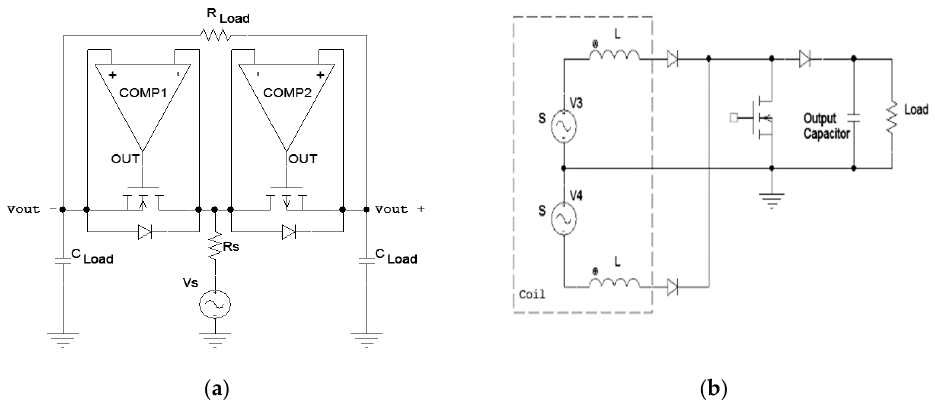
Figure 2. Rectifying circuits for inductive harvesting devices: ( a ) active rectifier [9–11] and ( b ) two- generators full-wave rectifier